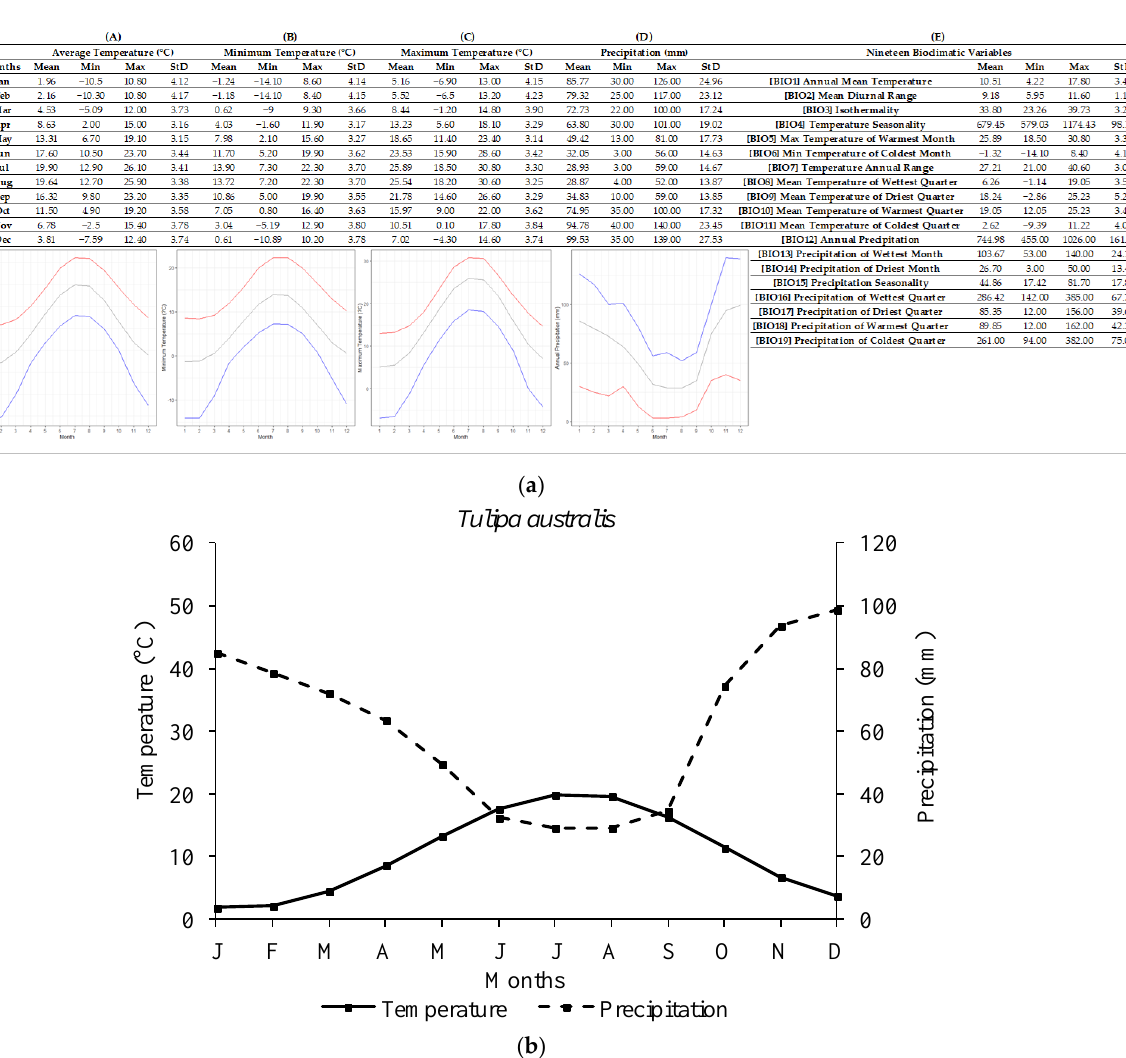
Figure 2. R-derived ecological profile ( a ) and Walter–Lieth climate diagram ( b ) of Tulipa australis based on 55 Greek localities known to date ( n = 55). For ( A – E ), minimum, maximum, and average values and standard deviations are represented in different columns. Line graphs ( A – C ) illustrate the minimum (blue), the maximum (red), and the mean (grey) monthly temperature ( ◦ C) and the line graph ( D ) illustrates the minimum (red), maximum (blue), and mean (grey) monthly precipitation (mm). ( A ) shows the minimum temperature in each month ( ◦ C), ( B ) shows the maximum temperature in each month ( ◦ C), ( C ) shows the average temperatures per month ( ◦ C), ( D ) shows the precipitation in each month (mm), and ( E ) shows the values for each of the 19 bioclimatic